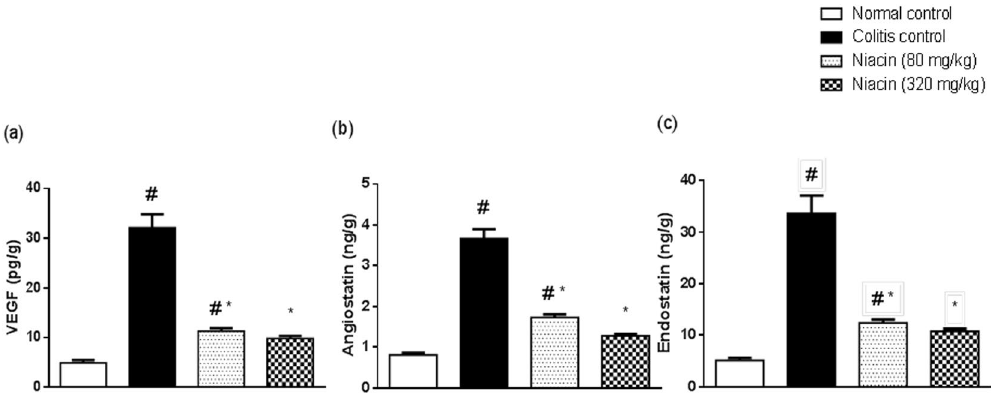
Figure 4. Effect of niacin on proangiogenic and antiangiogenic factors in colonic tissues of rats with iodoacetamide-induced colitis. (a) Vascular endothelial growth factor (VEGF), (b) angiostatin, (c) endostatin. Data are expressed as means ± SEM of 8 animals. # P ≤ 0.05 vs. normal control, * P ≤ 0.05 vs. colitis control.